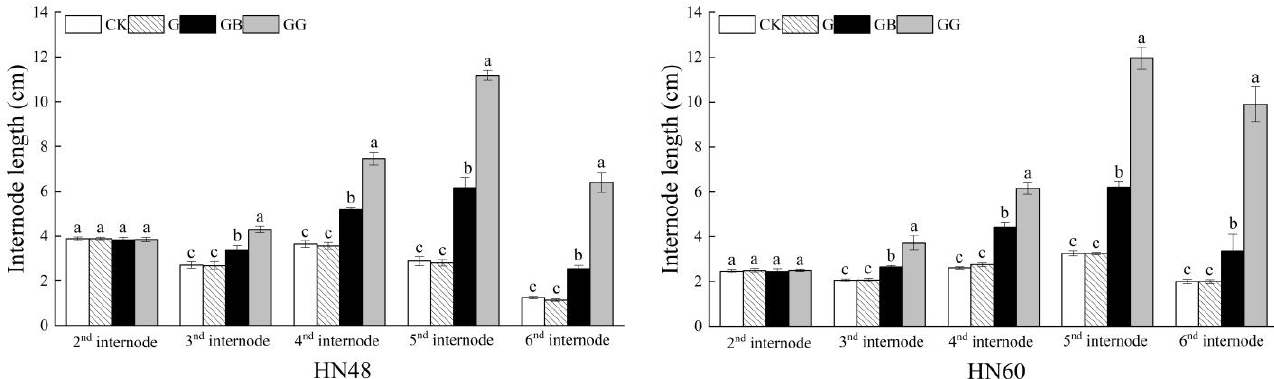
Figure 2. Effects of GA 3 application on soybean internode length after girding. The values are presented as the means ± standard errors ( n = 8). The different letters indicate that the differences between treatments reached a significance level of 5%; the treatments are compared longitudinally. CK: control; G: with girding and water application to the incision (water was applied through absorbent cotton at the girding site); GB: with girding and GA 3 application to the area below the incision at the 2nd internode (water was applied through absorbent cotton at the girding site); GG: with girding and GA 3 application to the incision (GA 3 was applied through absorbent cotton at the girding site).